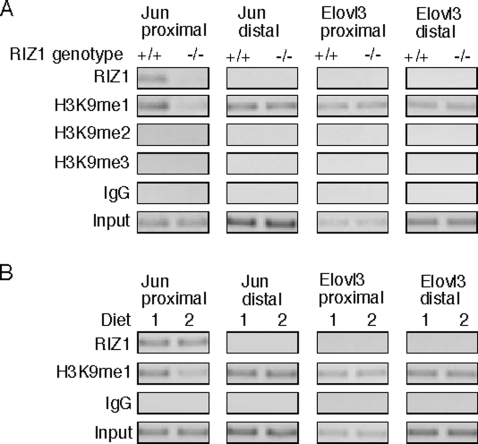
Regulation of histone methylation on RIZ1 target genes.A. Soluble chromatin was prepared from livers of RIZ1 wild type and knockout animals. Immunoprecipitation was performed using the indicated antibodies. DNA was amplified using primer sets that cover the proximal or the distal promoter regions of c-Jun and Elovl3 gene. B. Soluble chromatin was prepared from livers of wild type animals on either diet 1 or diet 2 for 1 month. Immunoprecipitation was performed using the indicated antibodies. DNA was amplified using primer sets that cover the proximal or the distal promoter regions of c-Jun and Elovl3 gene. One representative data set is shown out of four experiments performed.